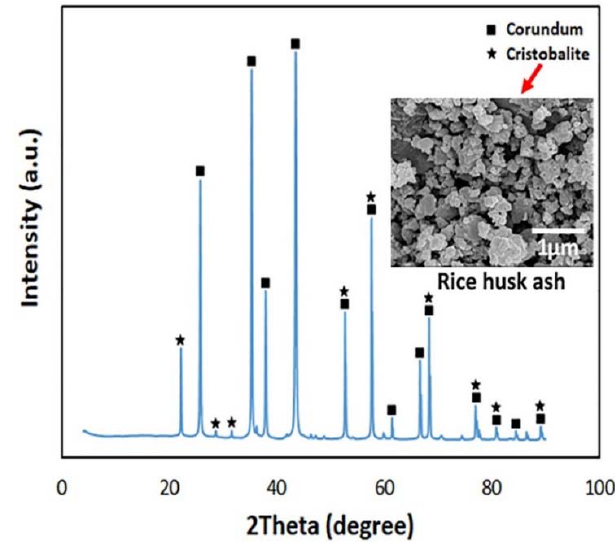
Figure 2. XRD pattern of RH-shaped porous Al 2 O 3 ceramics.